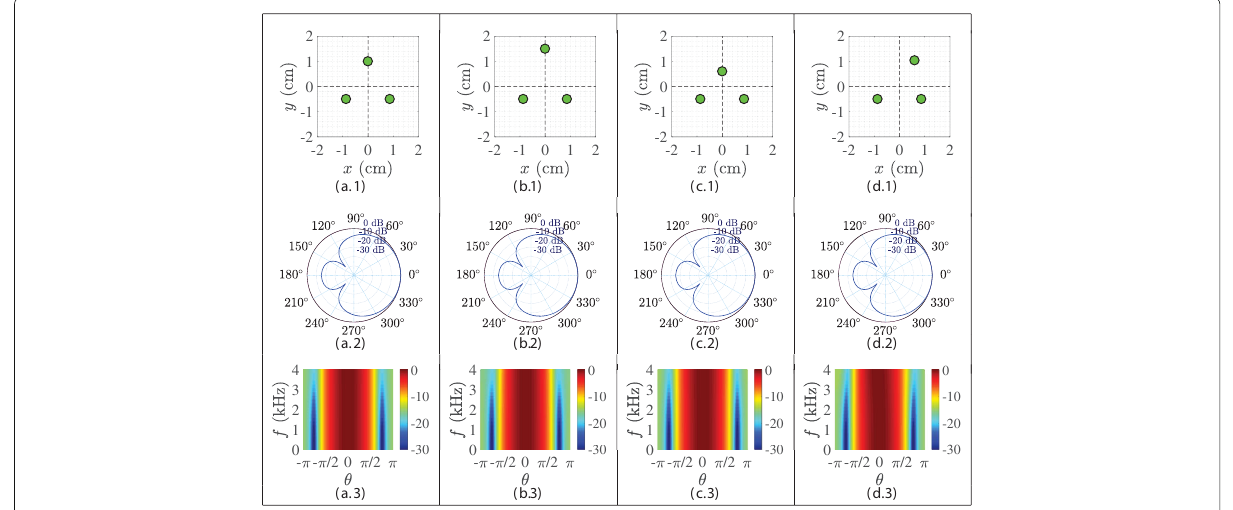
Fig. 1 The value of J n (ω r m / c ) for different values of